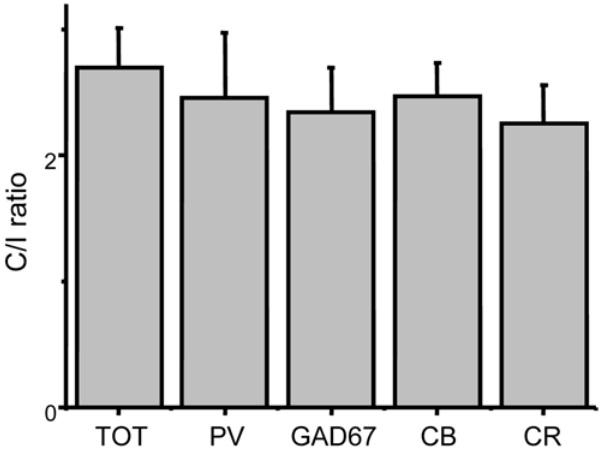
Figure 2. Contra/Ipsi ratio (C/I) of visual c-Fos induction in cortical neurons. The ratio between the number of c-Fos positive cells activated by contralateral and ipsilateral stimulation is reported. The TOT bar corresponds to the total cortical population. The other columns report the data for c-Fos positive cells double-stained with GAD67, PV, CB or CR. No significant difference is present (one way ANOVA, P=0.952).